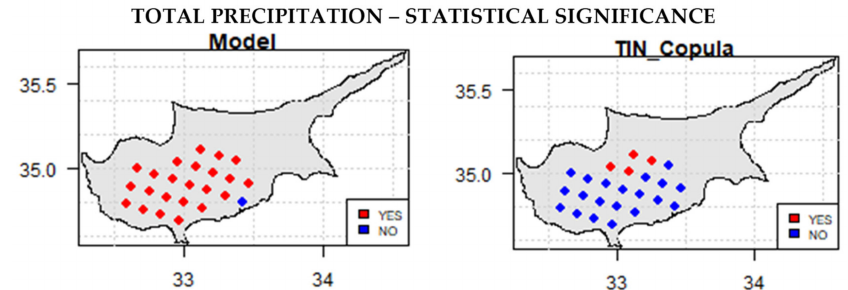
Figure 5. Grid points with statistically significant biases, before and after the application of the TIN-Copula bias correction (t-test, level of significance 95%).